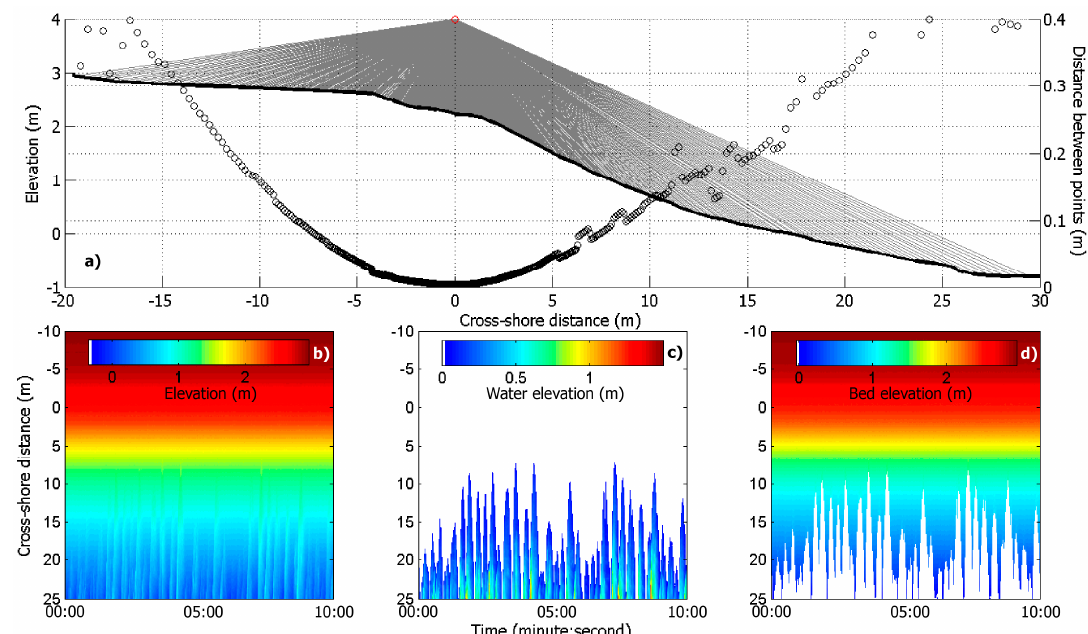
Figure 3. ( a ) Beach profile the Lidar position shown as a red circle and theoretical projection of the different laser beams on the topography of the beach. The distance between observations (black spots) is calculated as the horizontal distance between consecutive measurements of the laser beams ( a ); the lower panels show an example of raw Lidar time series ( b ) and post-processing products: water elevation ( c ) and bed altitude ( d ) time series.